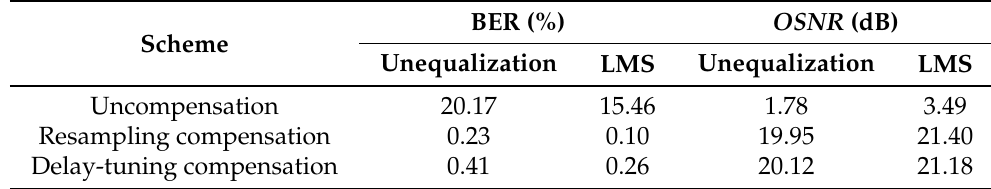
Table 3. The coded BER and OSNR under different communication schemes at unequalization and LMS equalizer conditions for sea experiment.